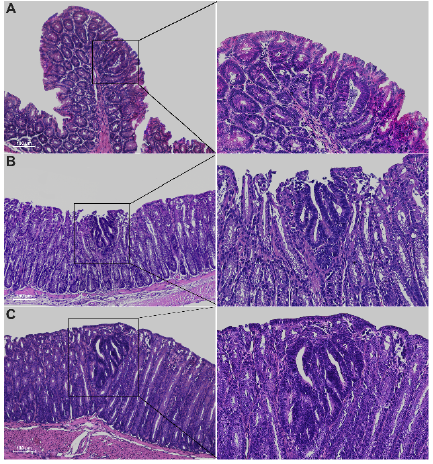
Figure 2. Hematoxylin and eosin staining on 3μm colon sections from proximal ( A ), medial ( B ) and distal ( C ) tracts of 5-week-old Winnie- APC Min/+ mice. Images were captured at 10× (left) and 20× magnifications (right).